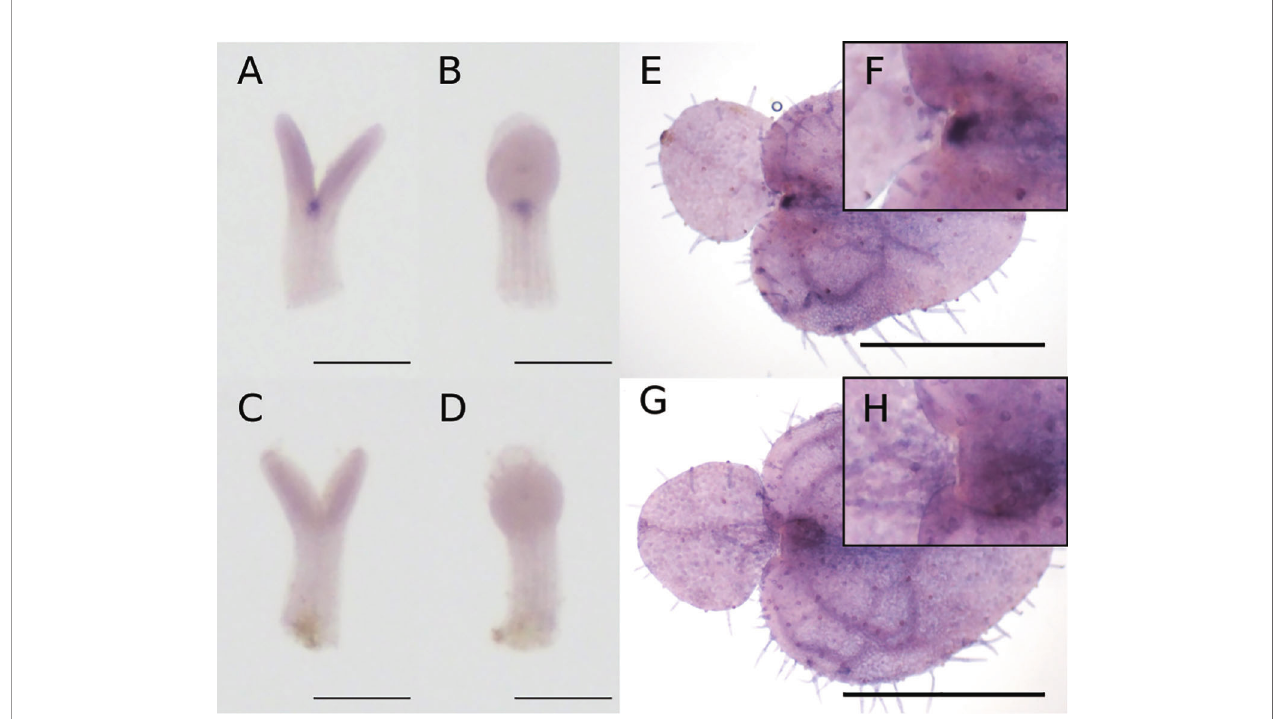
FIGURE 4 | WMISH of Mg-STM-B at the isocotyledonous stage (7 DAS) (A – D) and anisocotyledonous stage (18 DAS) (E – H) . (A, B, E, F) Antisense probe. (C, D, G, H) Sense probe. (A, C) Frontal view. (B, D) Side view. (F) Magni fi ed image of the GM in (E) . (H) Magni fi ed image of the GM in (G) . Bar = 200 µm in (A – D) , 1 mm in (E, G)